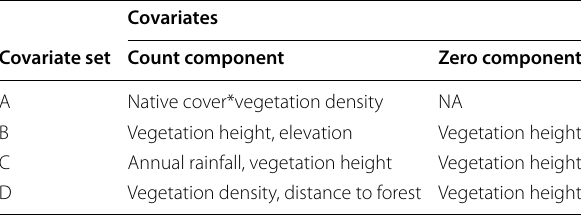
The zero-component terms, for covariate sets that had them, were excluded from GLMs and instead only the count-component terms were used due to the inability to separately model the count and zero processes using GLMs. *indicates the inclusion of an interaction between model